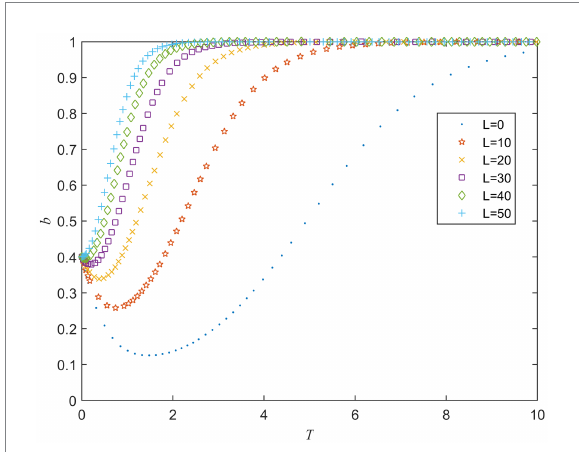
FIGURE 6 Strategy evolution of the private sector under different values of L .